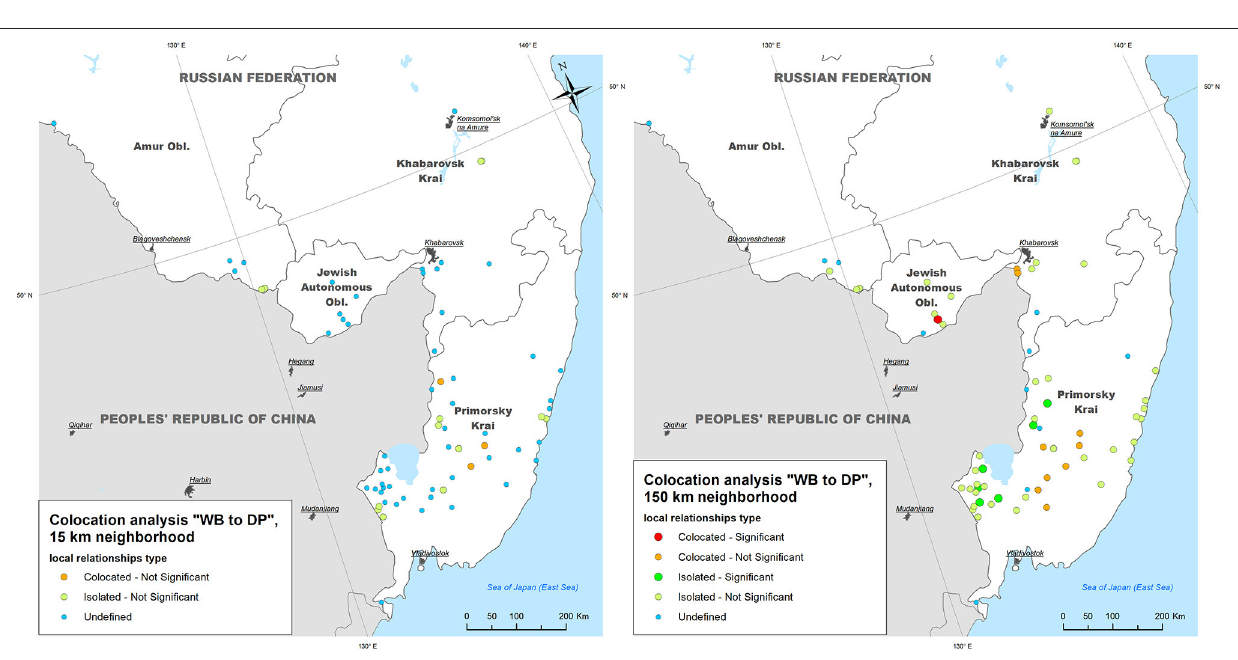
in a large epidemic involving both DP and WB.